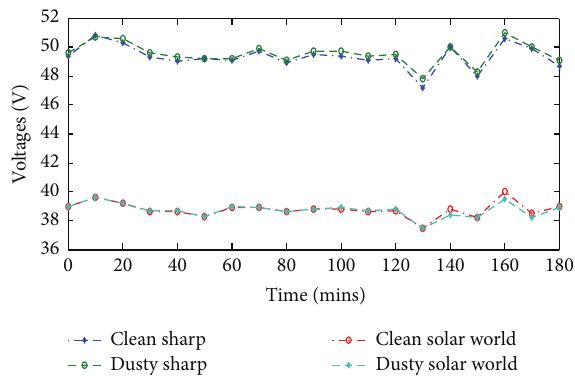
Figure 10: Voltage-time on day six (12:00–15:00